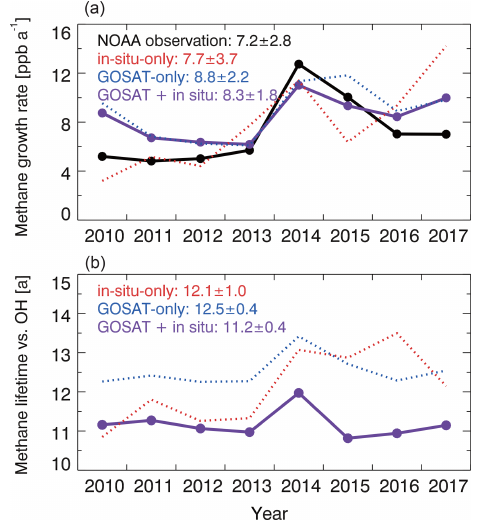
Figure 7. (a) Annual global growth rate of atmospheric methane, 2010–2017. Results from our three different inversions (in-situ- only, GOSAT-only, and GOSAT + in situ) are compared to the ob- served growth rates inferred from the NOAA surface observational network (https://www.esrl.noaa.gov/gmd/ccgg/trends_ch4/, last ac- cess: 20 June 2020). Mean annual growth rates and standard devi- ations from the different inversions are shown inset. (b) Methane lifetime against oxidation by tropospheric OH, 2010–2017, from the three different inversions. Mean lifetime and standard devia- tions are shown inset. The methane lifetime in the prior estimate is 10.6